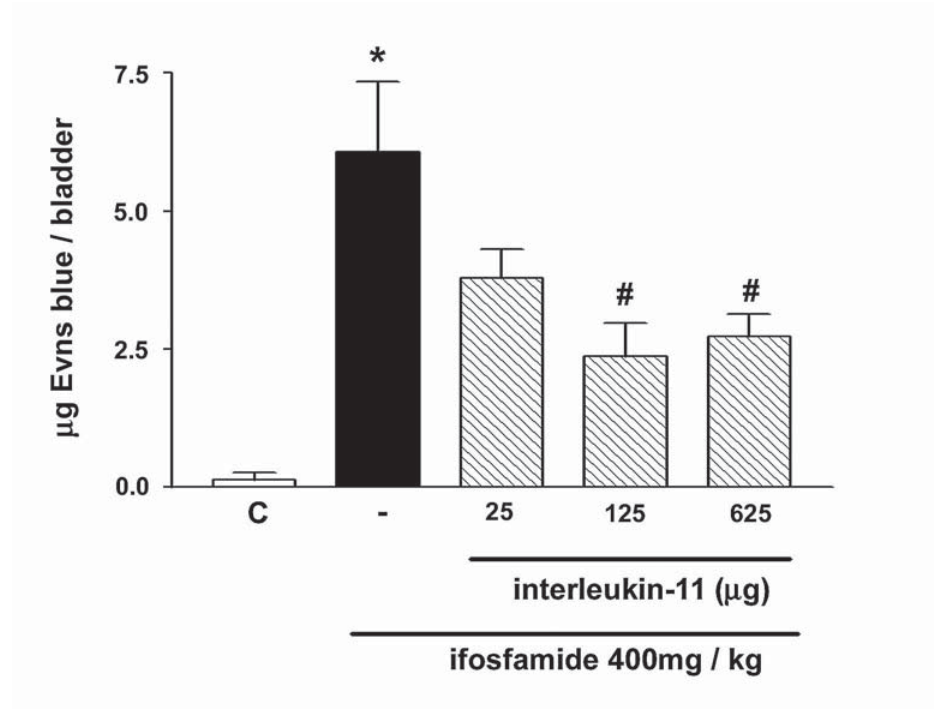
Figure 3 – Protective effect of rhIL-11 against ifosfamide-induced Evans blue extravasation in bladder. Ifosfamide at 400 mg/kg induced an increase in Evans blue extravasation when compared to the control group (C), thus demonstrating an increase in vascular permeabil- ity. rhIL-11 at 125 µ g and 625 µ g reduced ifosfamide-induced Evans blue extravasation. * p < 0.05 compared with control group. # p < 0.05 compared to ifosfamide only group. ANOVA followed by